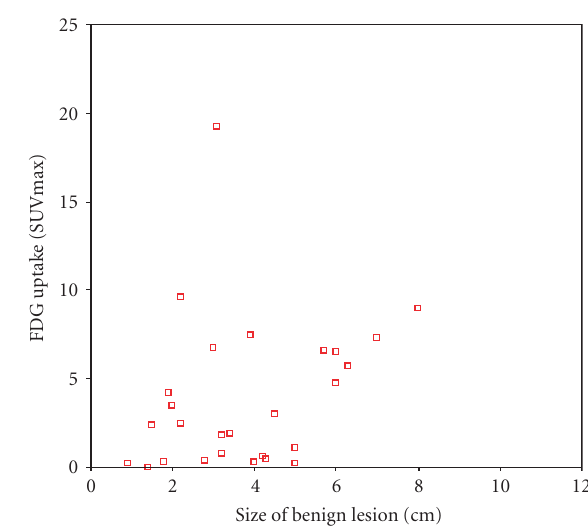
Figure 2: The correlation between FDG uptake and the sizes of 26 benign